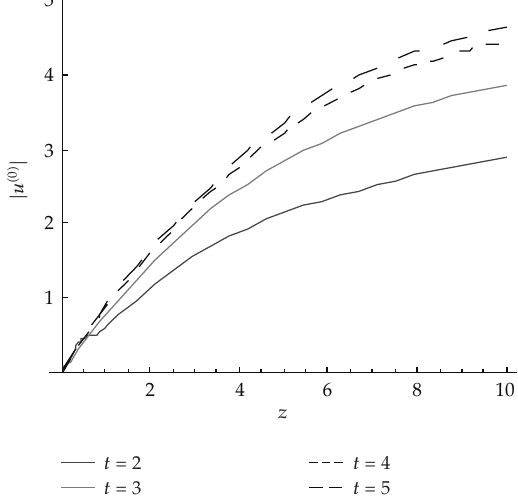
Figure 30: The zero-order approximation | u (cid:3) 0 (cid:4) | at α (cid:8) 1, T (cid:8) 10, γ (cid:8) 02 for di ff erent values of t , considering only one term in the series (cid:3) M (cid:8) 1 (cid:4)